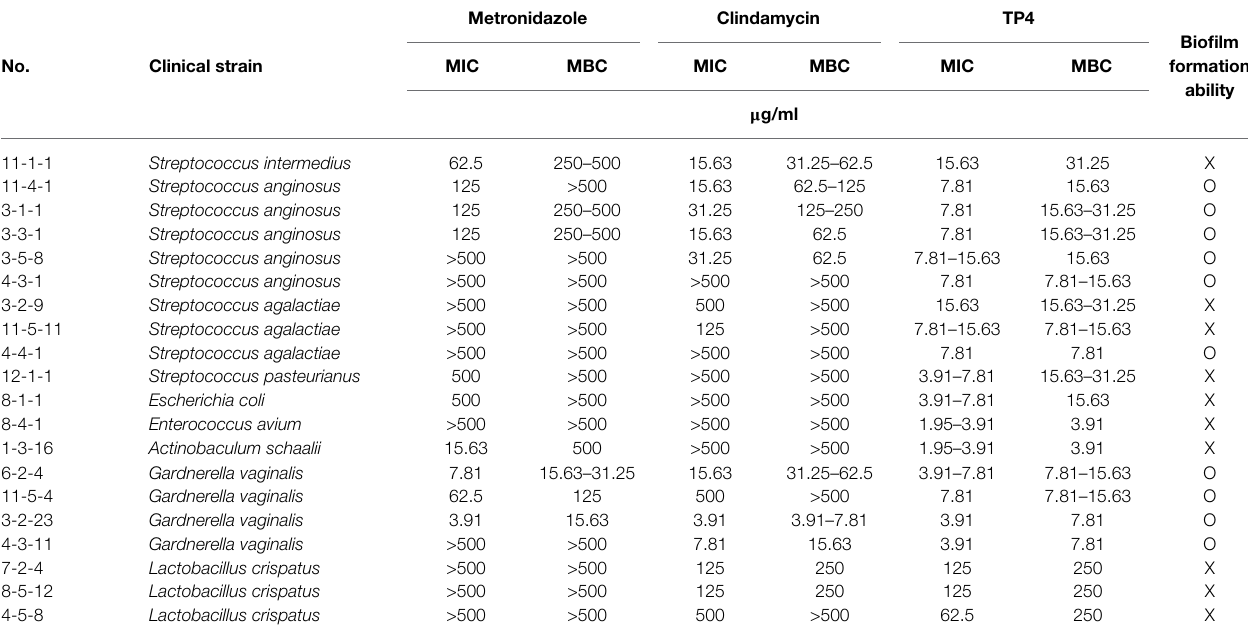
TABLE 1 | Minimal inhibitory concentrations (MICs) and minimum bactericidal concentrations (MBCs) of tilapia piscidin 4 (TP4) and antibiotics tested on clinical isolates of bacterial vaginosis (BV)-associated bacteria and vaginal lactobacilli.